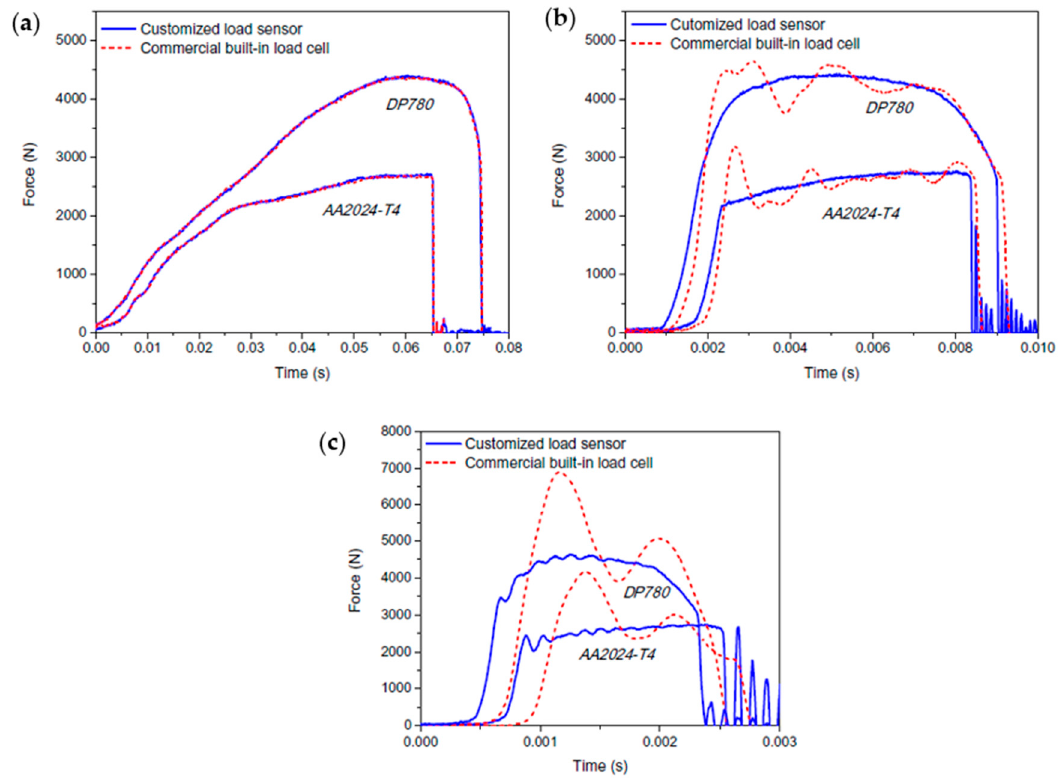
Figure 10. Load signals measured by the two different load sensors under ( a ) 10 s − 1 ; ( b ) 100 s − 1 ; and ( c ) 200 s − 1 (DP780: An advanced high strength steel and 2024-T4an aluminum alloy) (the figure is reproduced from [74], with permission from the Elsevier, 2016).